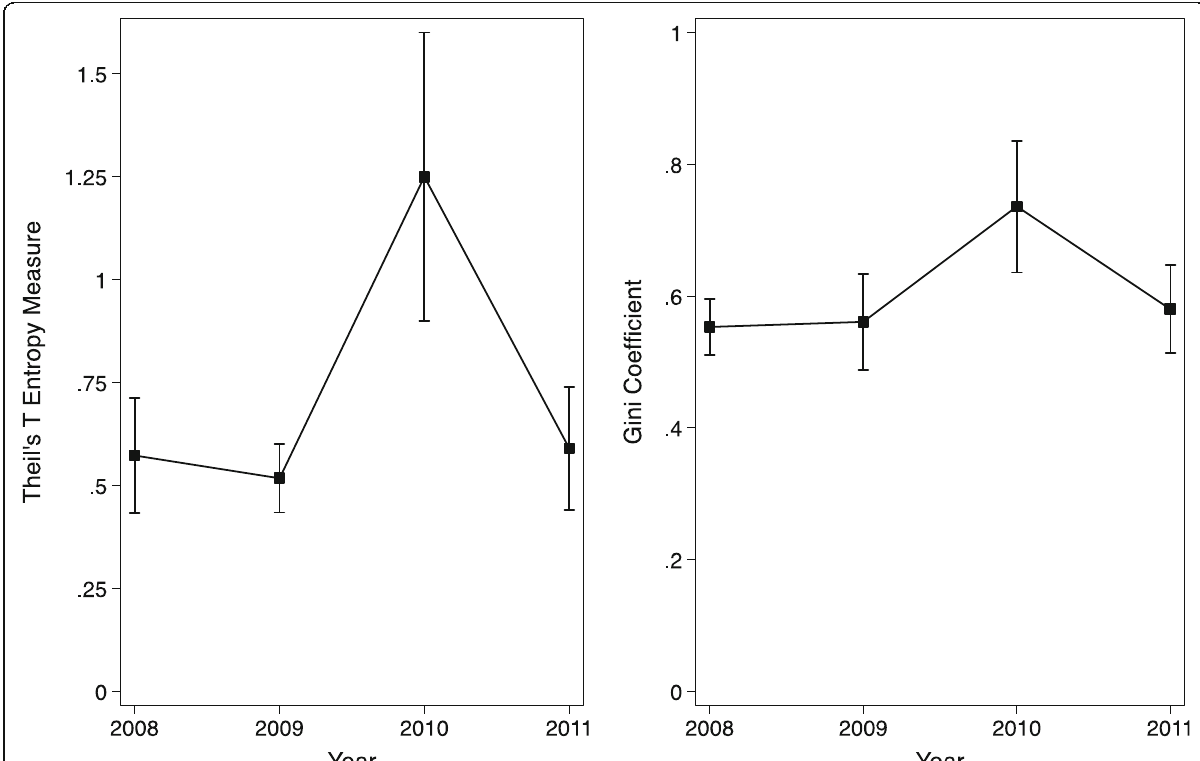
Figure 14 Theil ’ s T and the Gini coefficient, two indices of inequality, plotted for each year of the study. Capped bars indicate standard error and confidence intervals around the mean. As we saw in Figure 13, inequality decreases in bad rainfall years (2009) and increases dramatically in the first year following a drought event. Inequality then declines in the second year following the drought event, either approaching or equivalent to pre-drought